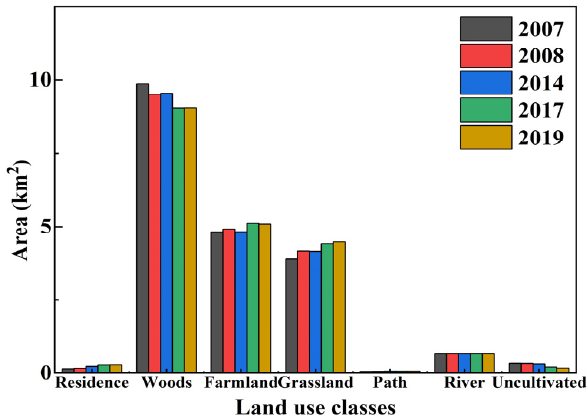
Figure 16. Land use in different years.